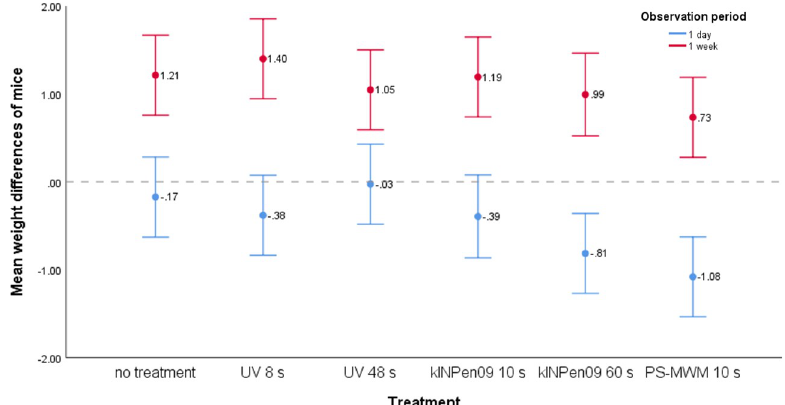
Fig 4. Body weight. Mean weight differences (95% CI) of mice broken down by observation period, treatment and treatment duration (N = 178). Weight decreased one day after treatment and weight increased one week after treatment. Mice receiving PS-MWM showed the highest weight loss and lowest weight gain. However, significant differences were only found after one day between mice receiving PS-MWM and mice without treatment (p = .013) as well mice receiving UV for 48 seconds (p = .002). The treatment duration had no impact on weight